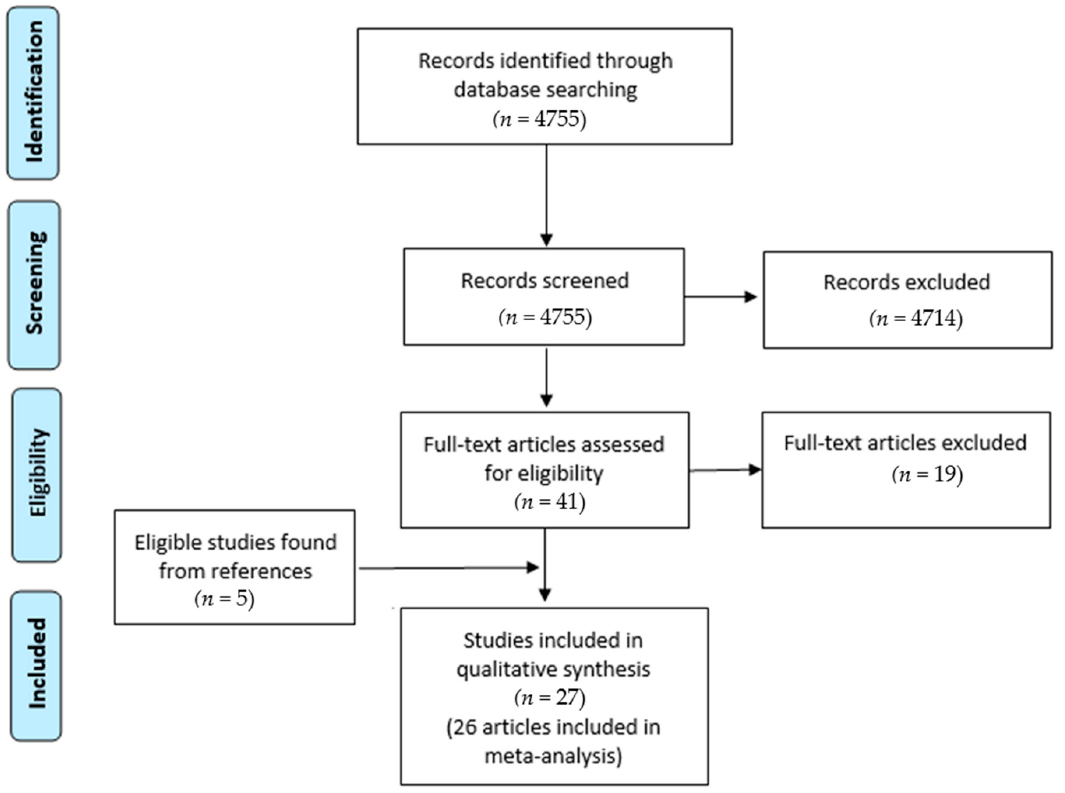
Figure 1. PRISMA Figure 1. PRISMA flowchart.